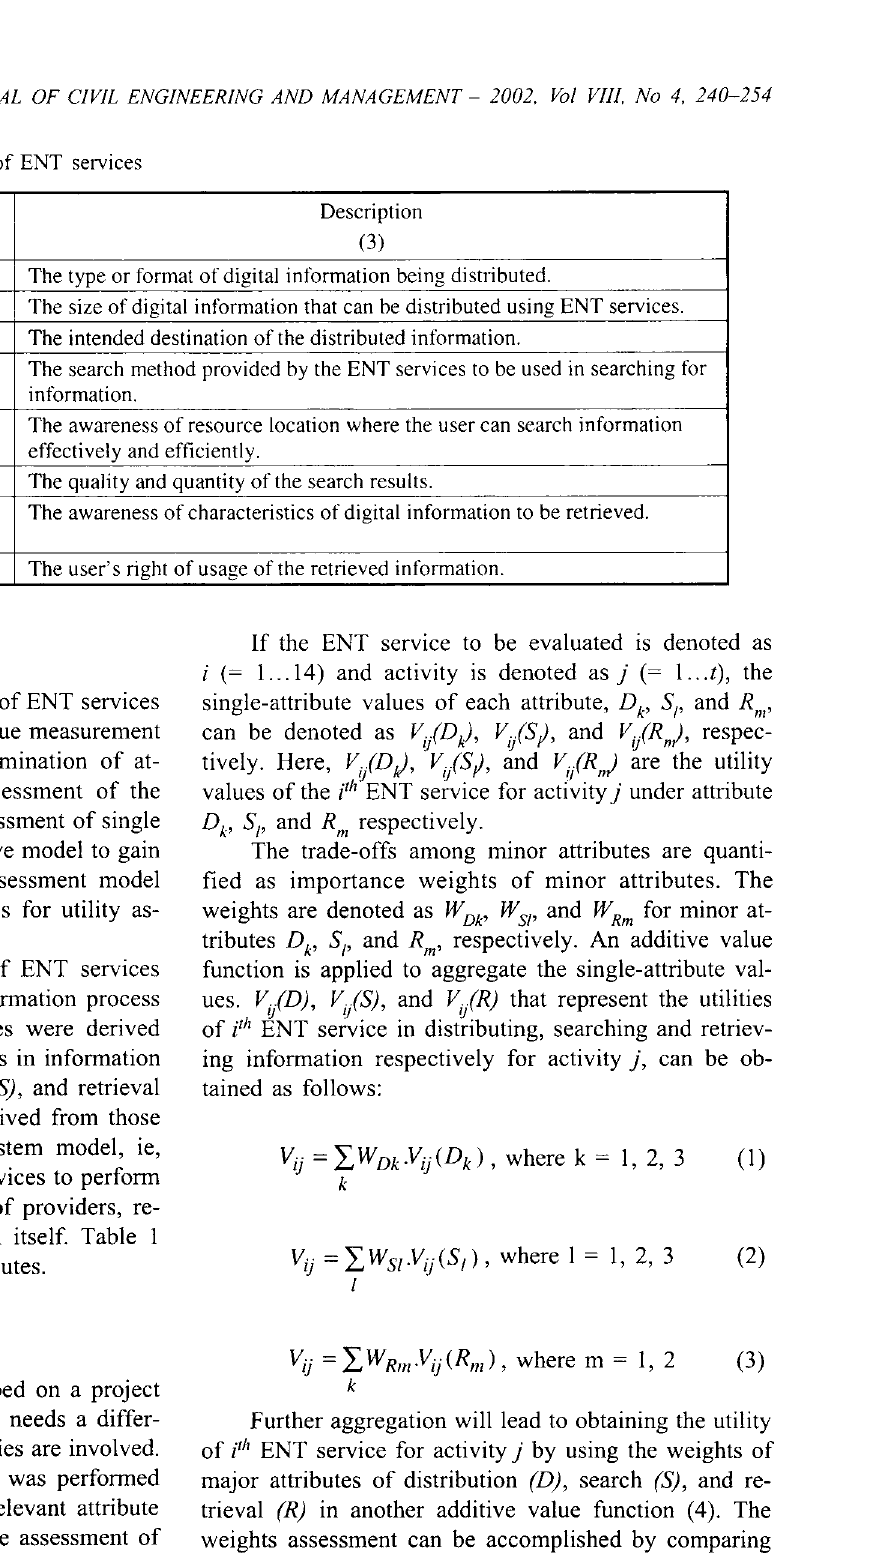
Table 1. Attributes for assessing the utility of ENT services Major